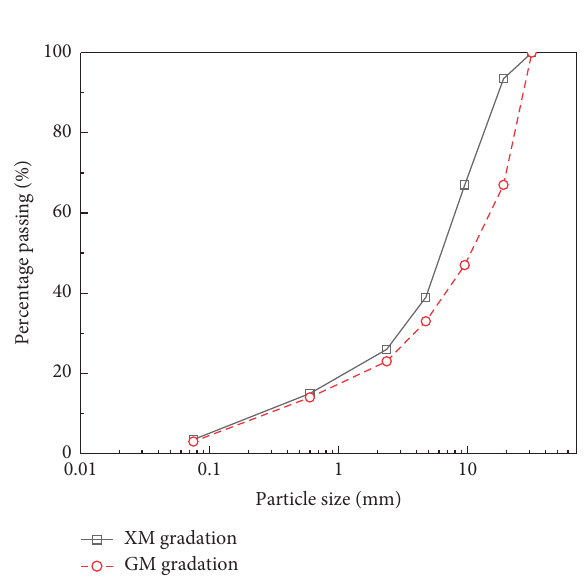
Figure 1: Aggregate gradation curves of